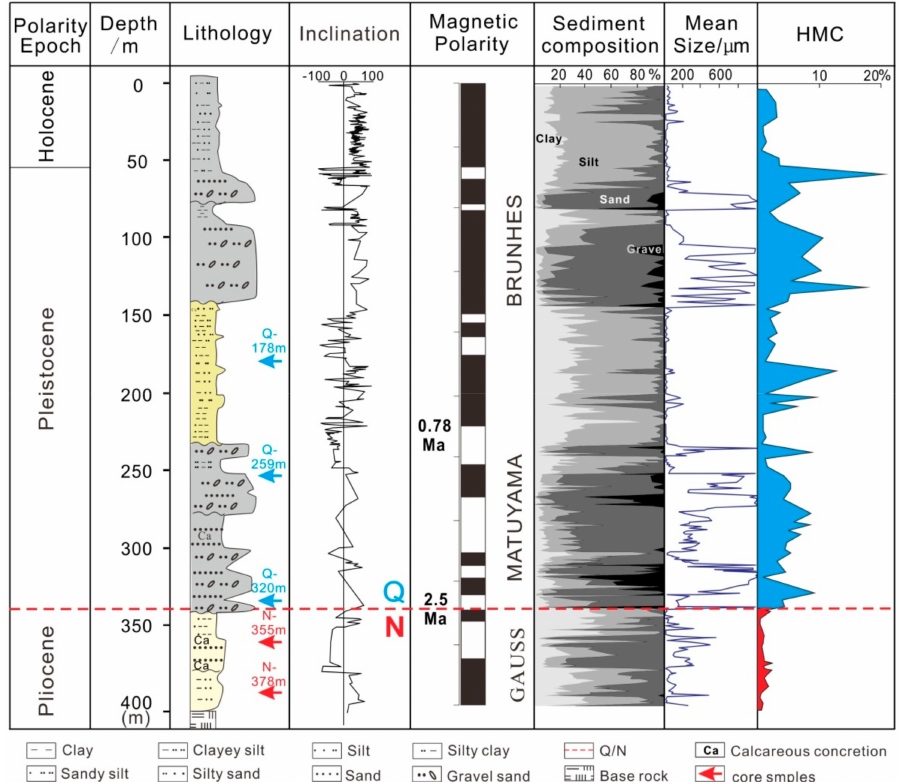
Figure 2. The Plio-Pleistocene magneto-stratigraphy of Core LQ24 from the Changjiang Delta. Paleo-magnetic dating, lithology, and grain size parameters were from [3]. N = Pliocene, Q =